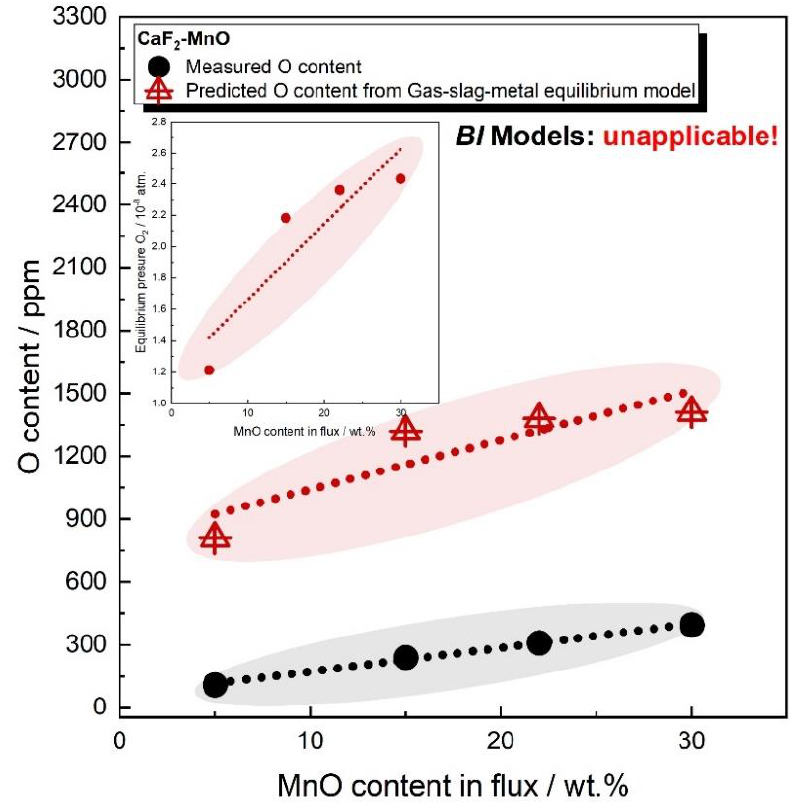
Figure 9. WM O content and equilibrium p O2 as a function MnO content in flux.